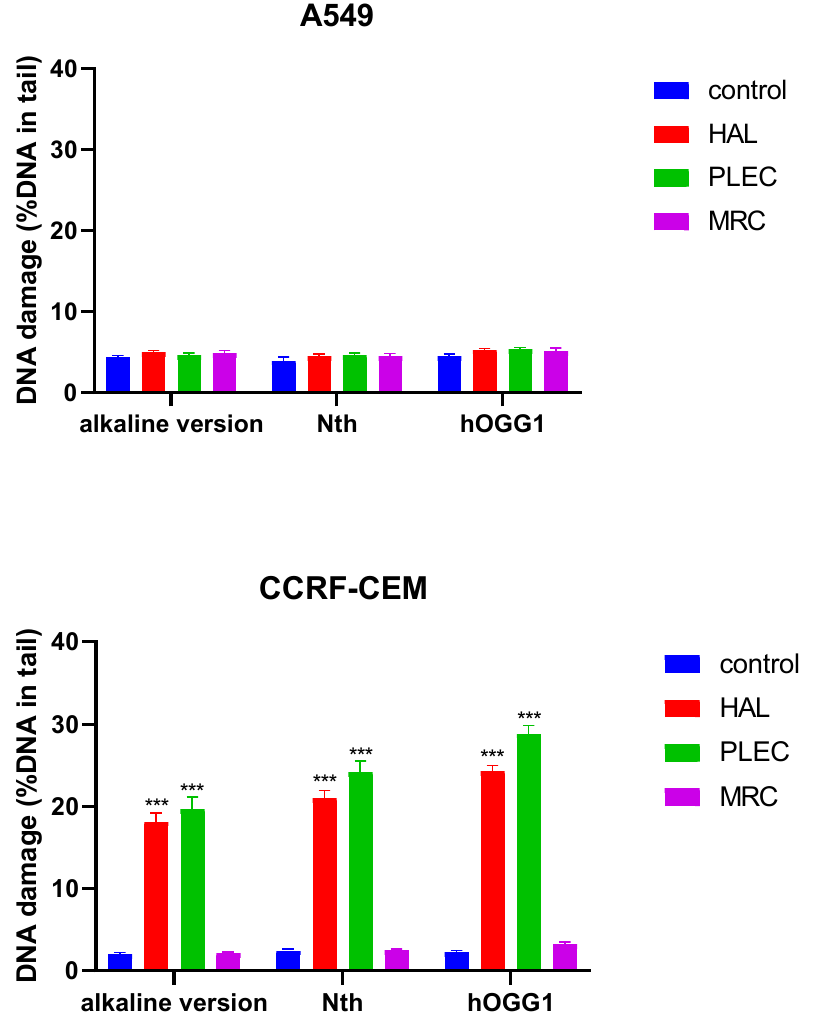
Figure 7. Mean level of DNA strand breaks, alkali-labile sites and oxidative DNA damage induced by HAL, PLEC and MRC in of A549 and CCRF-CEM cells, measured as mean % comet tail DNA in alkaline comet assay. Error bars denote SEM, *** p < 0.001 vs. control cells.